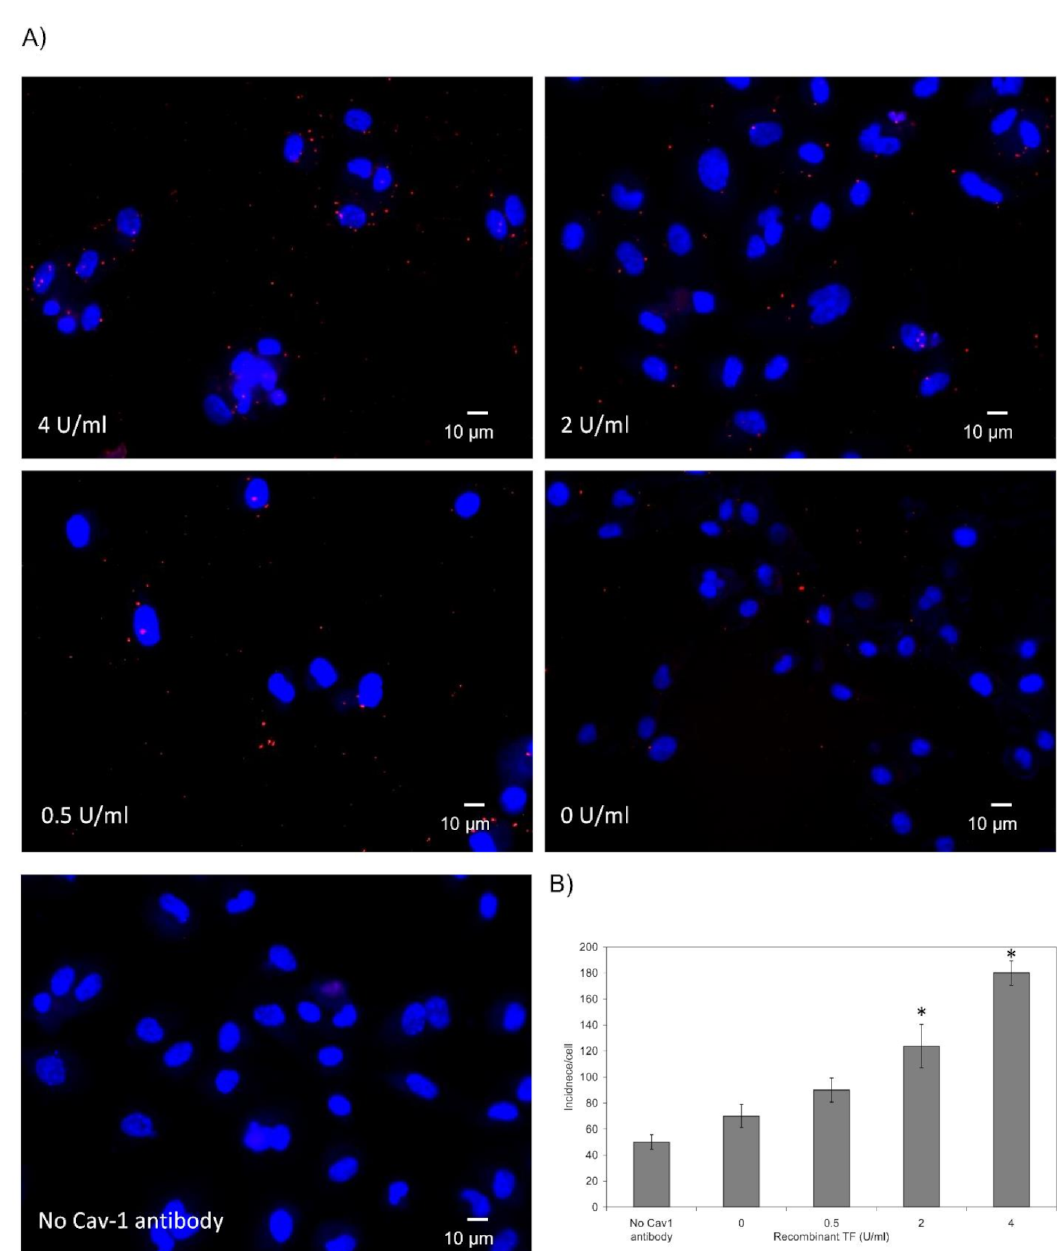
Figure 5. Analysis of the association of recombinant TF with caveolin-1 on the surface of HDBEC: HDBEC cells (2 10 3 ) were seeded out into 96-well plate based µ -dishes overnight and treated with recombinant TF (4 U/mL). Cells were then fixed with 4% ( v / v ) paraformaldehyde for 15 min, washed three times with PBS for 5 min and blocked with Duolink blocking buffer for 1 h. The cells were then incubated overnight at 4 ◦ C with a mouse anti-TF antibody (10H10; 5 µ g/mL) and a polyclonal rabbit anti-caveolin-1 antibody (10 µ g/mL). ( A ) The dishes were washed three times with PBS and PLA performed according to the manufacturer’s instructions. The cells were stained with DAPI (2 µ g/mL) and images were acquired using a Zeiss Axio Vert.A1 inverted fluorescence microscope with a 40 magnification. A different representative of the control samples in which one primary antibody was substituted with a isotype control, is presented in each of the figures. ( B ) The number of red fluorescent events and nuclei were determined as incidence/cell in 10 fields of view from each assay using the ImageJ program. ( n = 3; * = p < 0.05 vs. No TF sample).